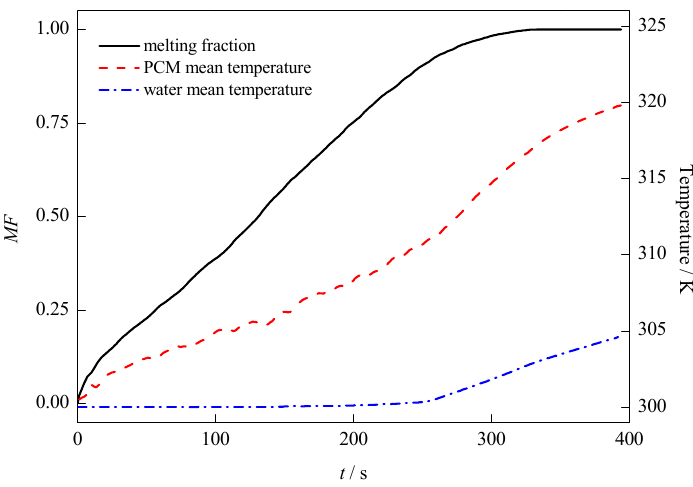
Figure 3. Evolution of the melting fraction, mean PCM temperature, and mean water temperature for the default configuration.